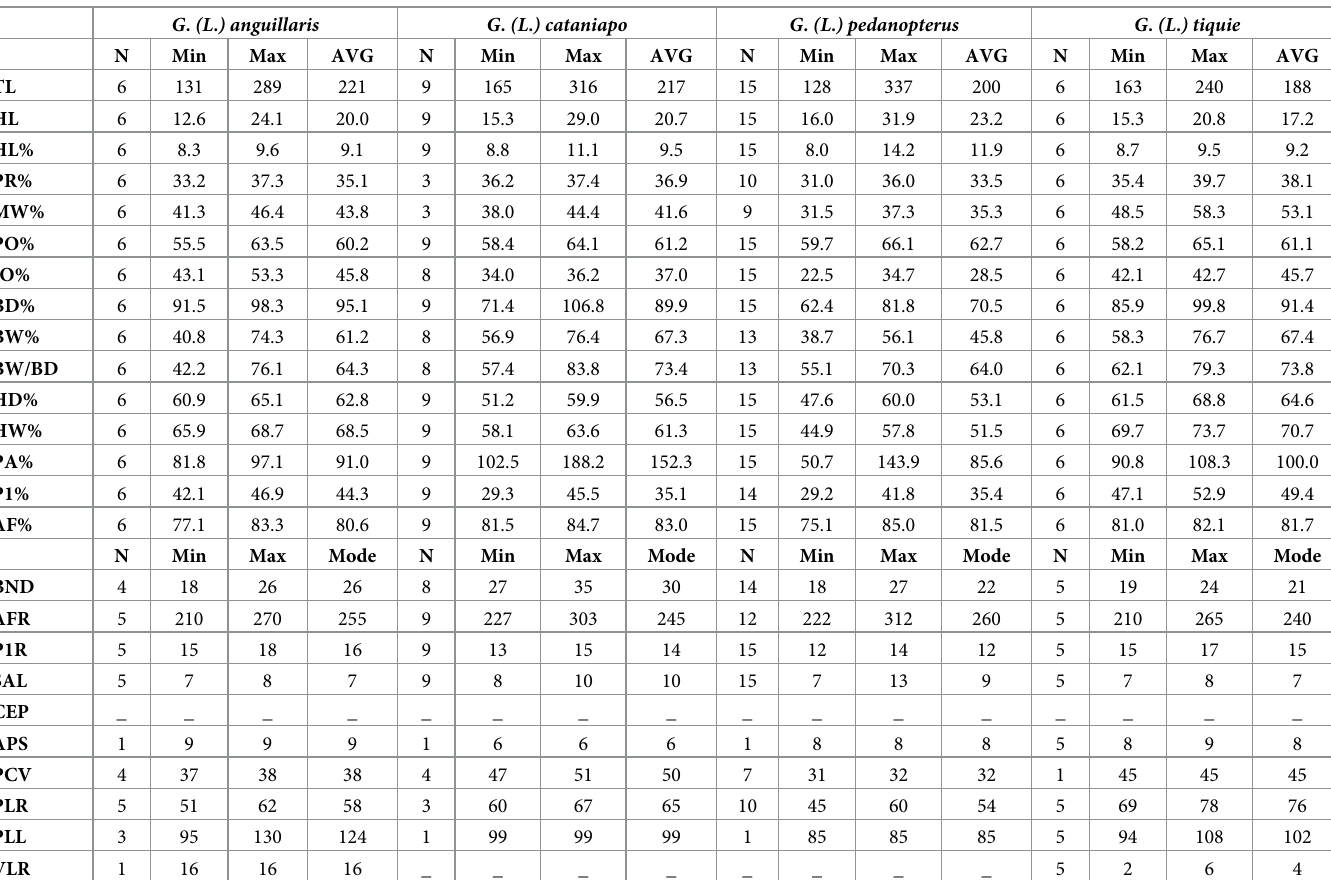
Table 13. Summary of morphometric and meristic data for four valid species of Lamontianus . Data for 36 specimens. G . (L . ) anguillaris G . (L . )